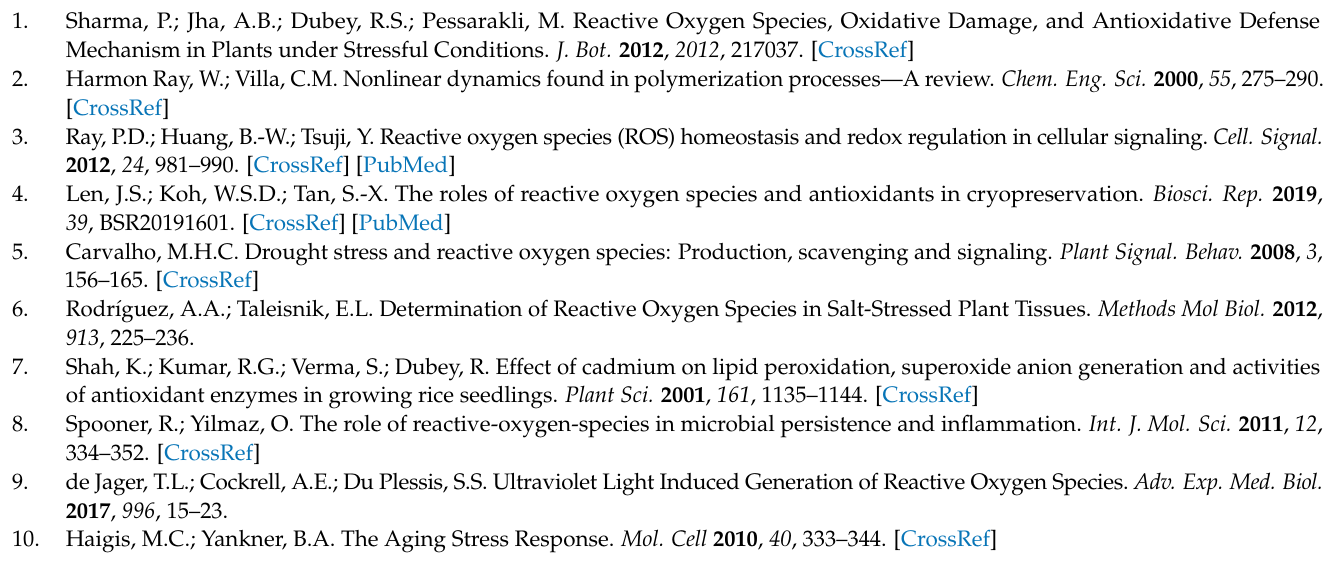
conditions from data in Figure 3a, Table S2: Student’s t -test results from time point comparisons of data in Figure 3a, Figure S1: Q–Q normality plot of control and test conditions from data in Figure 3a, Figure S2: Tentative structure of FucoPol based on preliminary experimental data. The structure presented is a deacetylated, desuccinylated form of the